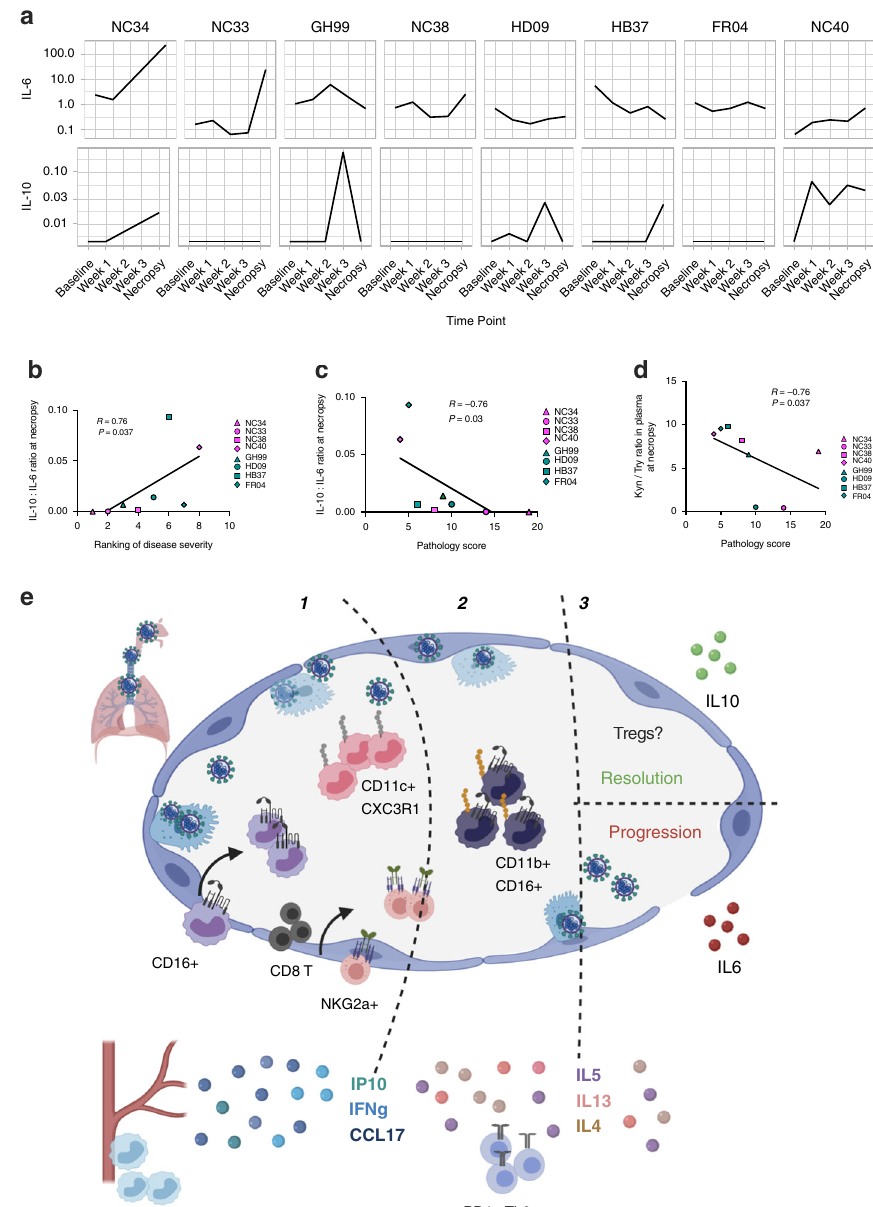
Fig. 6 Increased IL-6 in the absence of IL-10 is associated with disease progression. Levels of IL-6 and IL-10 in plasma over time (pg/mL) ( a ) and b correlation between the ratio of IL-10 to IL-6 levels measured in plasma and the ranking of disease severity or c with pathology score ( n = 8), by the Spearman correlation test. d Association between Kyn/Tryp ratio in plasma (pg/mL) and pathology score ( n = 8, Spearman test). e Summary of immune events in the lungs and blood of SARS-CoV-2 infected animals, from the 1-acute phase 2-switch to Th2-type responses and 3-resolution